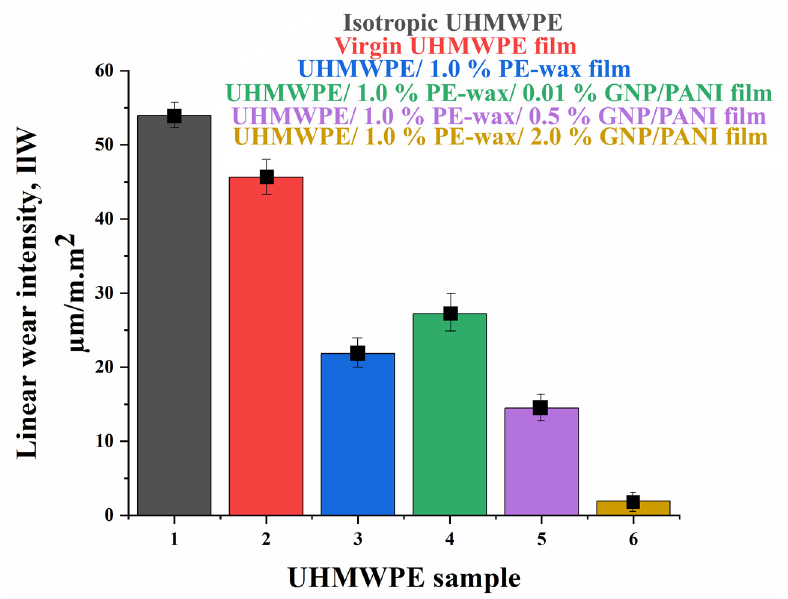
Figure 10. Linear wear intensity for UHMWPE samples obtained at drawing temperature of 140 °C, where (1) isotropic UHMWPE, (2) virgin-oriented UHMWPE, (3) oriented UHMWPE/1.0% PE-wax, (4) oriented UHMWPE/1.0% PE-wax/0.01% GNP/PANI, (5) oriented UHMWPE/1.0% PE-wax/0.5% GNP/PANI, and (6) oriented UHMWPE/1.0% PE-wax/2.0% GNP/PANI. All samples were obtained by first thermal orientation regime.